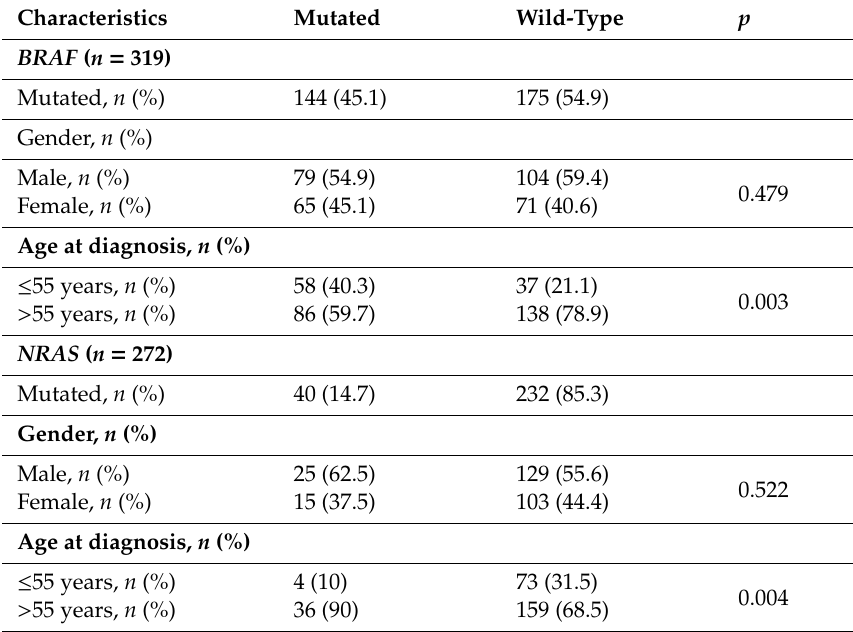
Figure 1. Tissue samples from advanced malignant melanoma (MM) patients analyzed for BRAF mutational status and screening methodologies used into the study. RT-PCR (written as rtPCR in the rest of the manuscript), real-time polymerase chain reaction; NGS, next-generation sequencing. Table 2. Patient mutational status at first test screening by conventional analysis. In bold, significant p -value